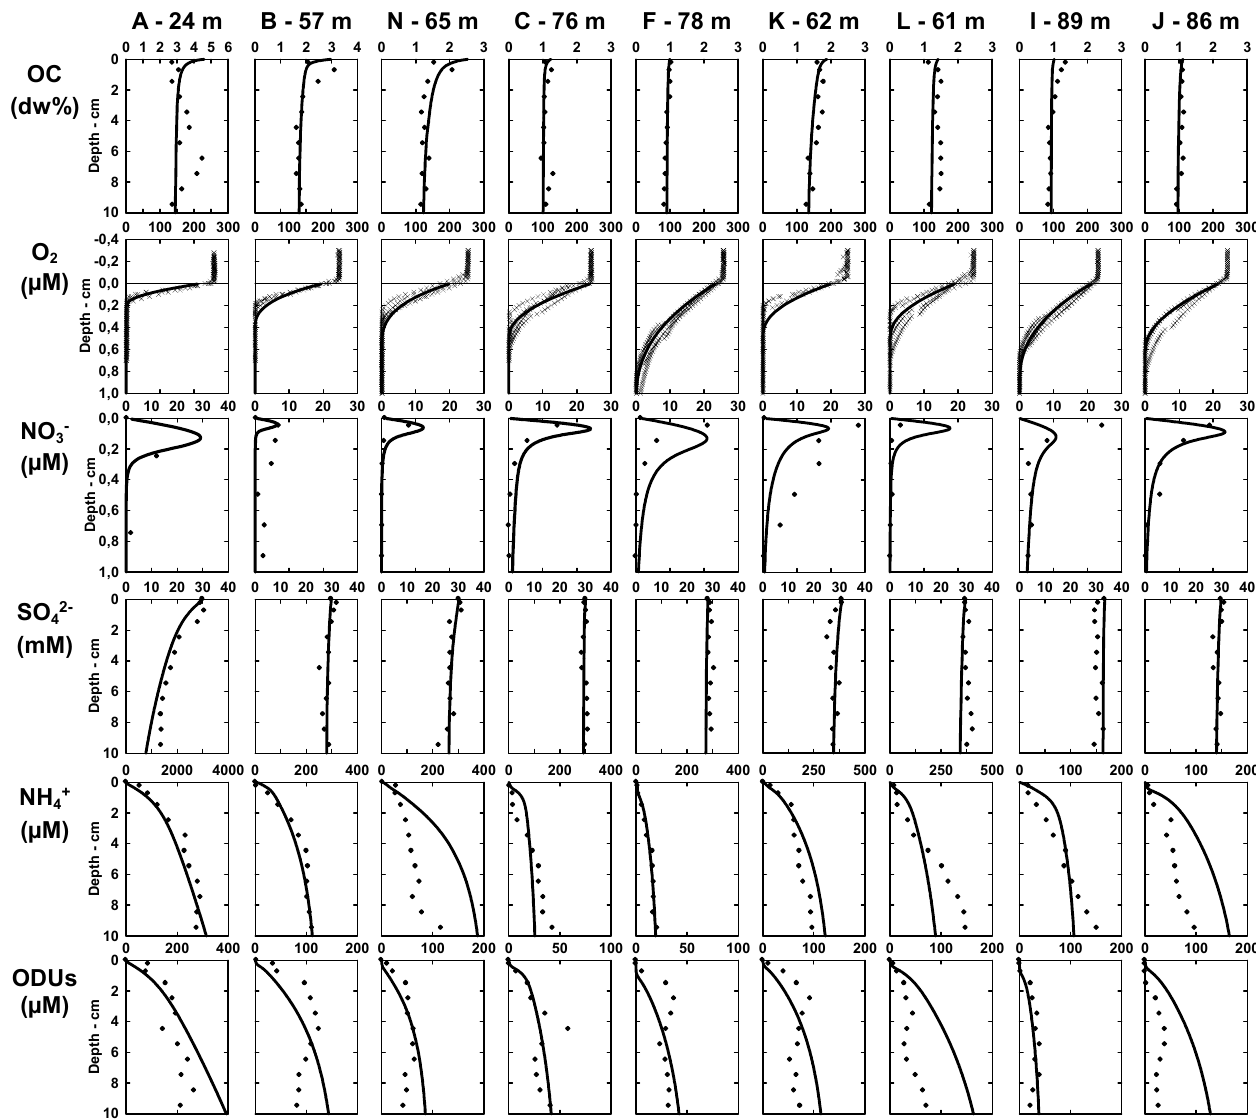
Fig. 3. Experimental profiles (symbols) and the best fit using the steady-state version of OMEXDIA, a numerical coupled diagenetic model (lines) in all sites. Note that different scales are used for different